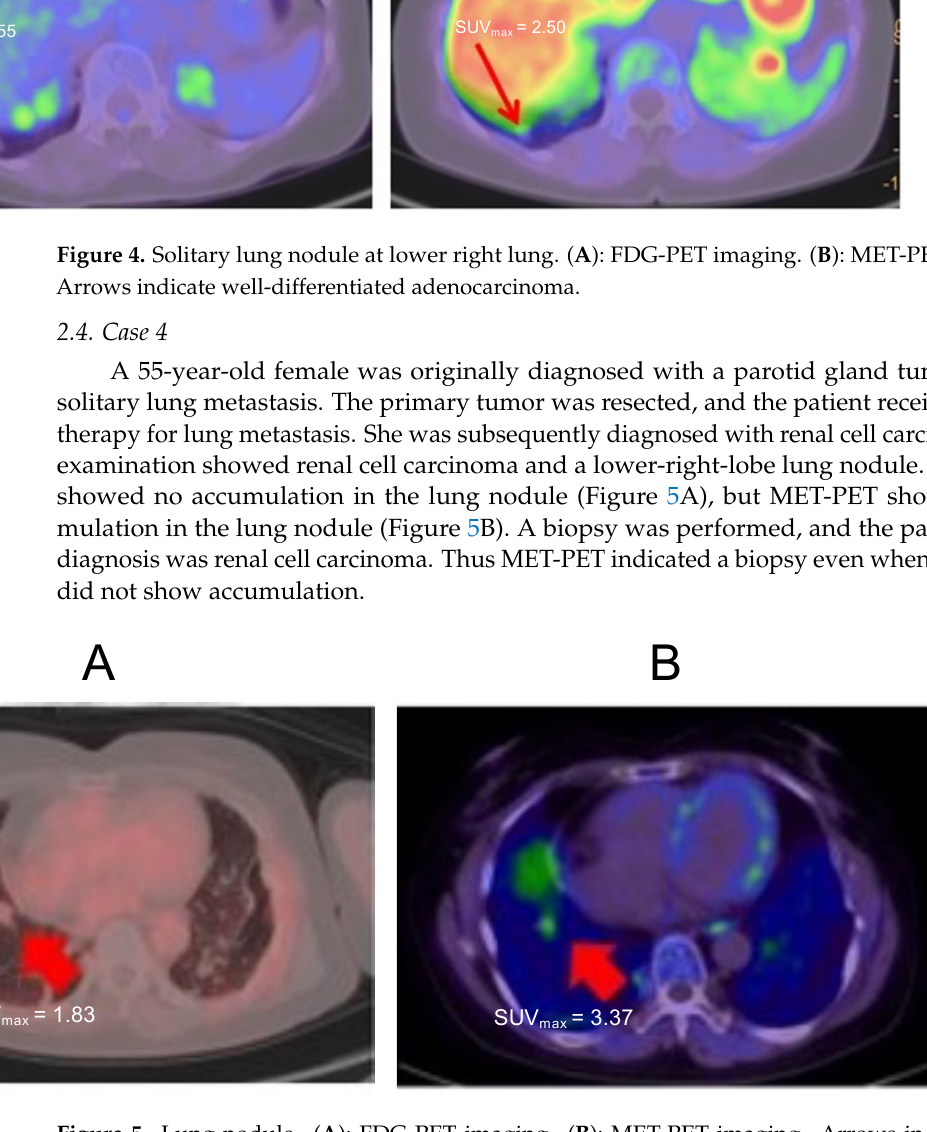
Figure 3. Lung tumors at both sides of the lung apex. ( A ): FDG ‐ PET imaging. ( B ): MET ‐ PET imaging. The red arrows indicate cancer, and the blue arrow indicates granuloma.